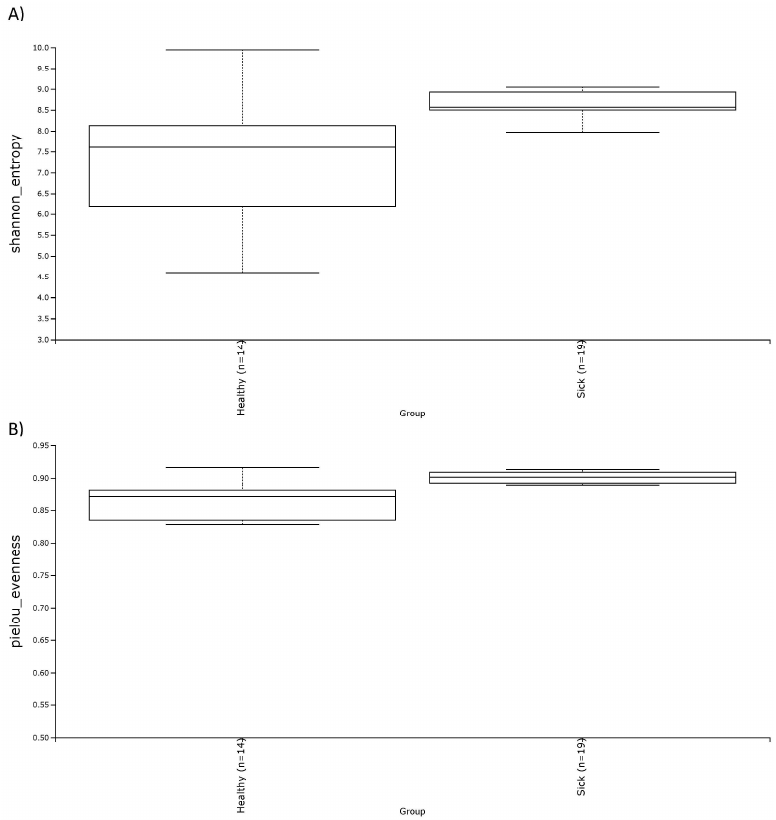
Figure 2. Alpha diversity, shown as the median of the Shannon index ( A ) and the Evenness index ( B ), in blood samples of healthy and sick dogs. Table 2. Non parametric Kruskal–Wallis test of the Shannon and Evenness alpha diversity indexes and PERMANOVA analysis of the weighted and unweighted UniFrac dissimilarity matrix on the blood microbiome of healthy and sick dogs. p -value below 0.05 denoted significance.